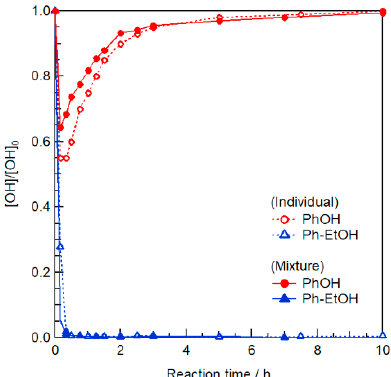
Figure 2. Effect of the amount of EmimOAc (3.8 mol L − 1 ) on the transesterification of individual PhOH and Ph-EtOH or their mixture (0.38 mol L − 1 each) under excess IPAc (1.14 mol L − 1 ) for 10h at 80 °C determined as changes in relative contents by in situ 1 H NMR in DMSO- d 6 .